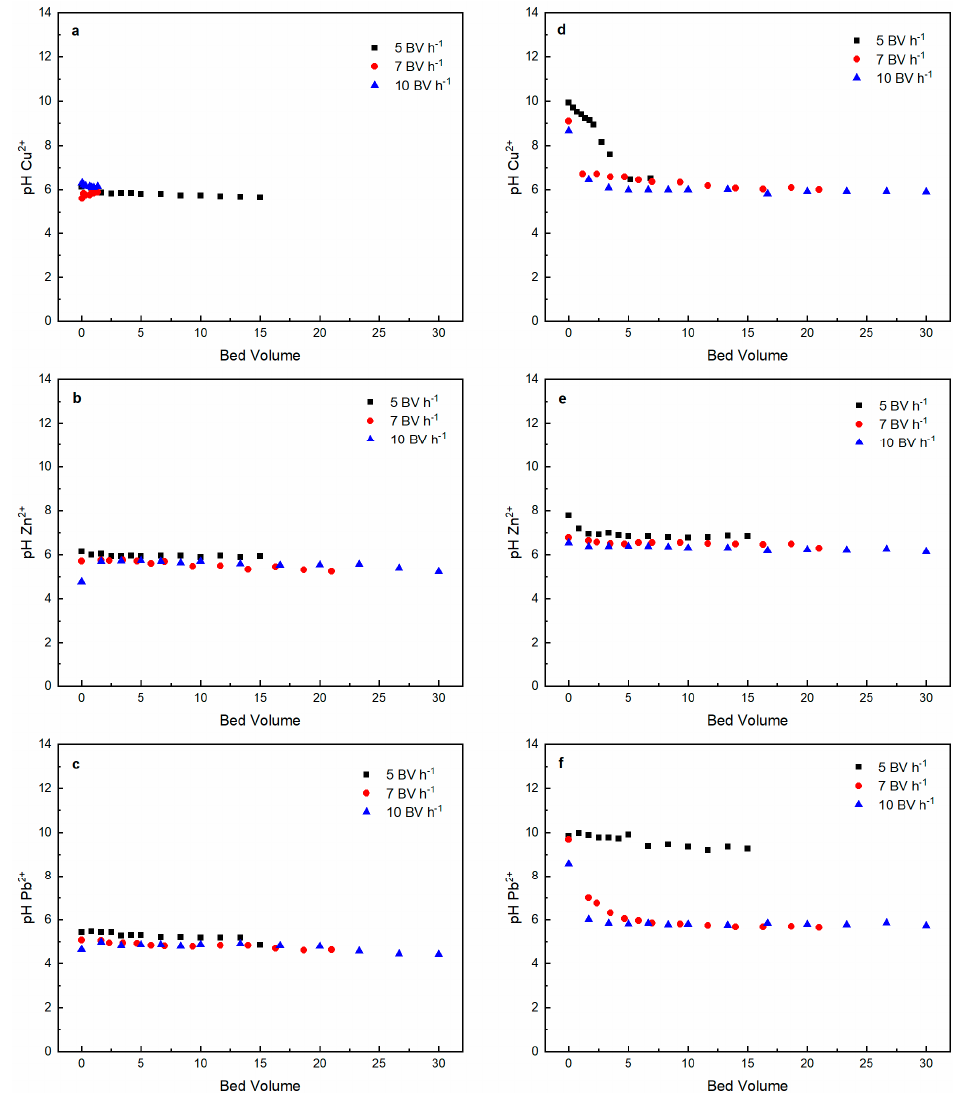
Figure 3. pH studies using clinoptilolite leaching Cu 2+ ( a ); Zn 2+ ( b ); Pb 2+ ( c ) and zeolite A leaching Cu 2+ ( d ); Zn 2+ ( e ); Pb 2+ ( f ) .